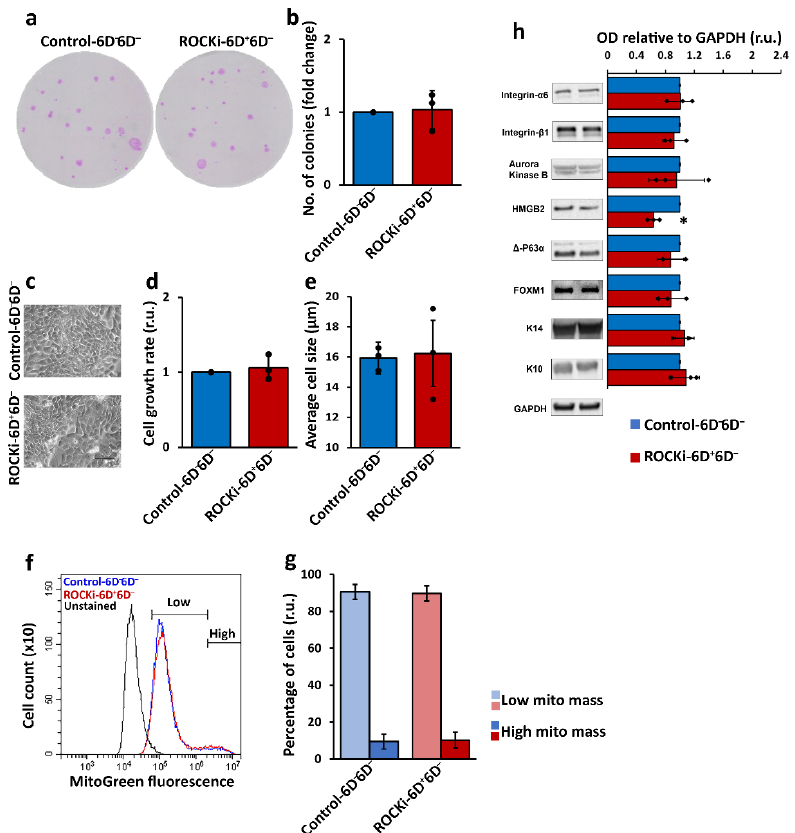
Figure 3. Cells reversed their proliferation status following withdrawal of ROCKi treatment. Control-6D − and ROCKi-6D + cells were passaged once and cultured without ROCKi (Control-6D − 6D − and ROCKi-6D + 6D − ) for additional six days. Colonies were stained with Rhodanile blue ( a ). No significant change in colony formation was detected in treated cells compared to non-treated cells ( b ). The morphology of cultured keratinocytes at day 6. Scale bar = 50mm ( c ). Quantification of the cell growth rate in treated cells compared to non-treated cells ( d ). Quantification of the change in average cell size in treated cells compared to non-treated cells ( e ). Histogram of mitochondrial mass in treated and non-treated cells stained with 200nM Mitotracker Green and confirmed by flow cytometry ( f ). Quantification of the change in cell population with high mitochondrial mass in treated cells compared to non-treated cells ( g ). Left panel shows the images of representative immunoblots with proliferation and differentiation markers with no differences between Control-6D − 6D − and ROCKi-6D + 6D − apart from HMGB2 ( h ). GAPDH was used as a loading control. The right panel shows the densitometry analysis for immunoblots. Data are presented as mean ± S.D., n = 3, * p < 0.05.